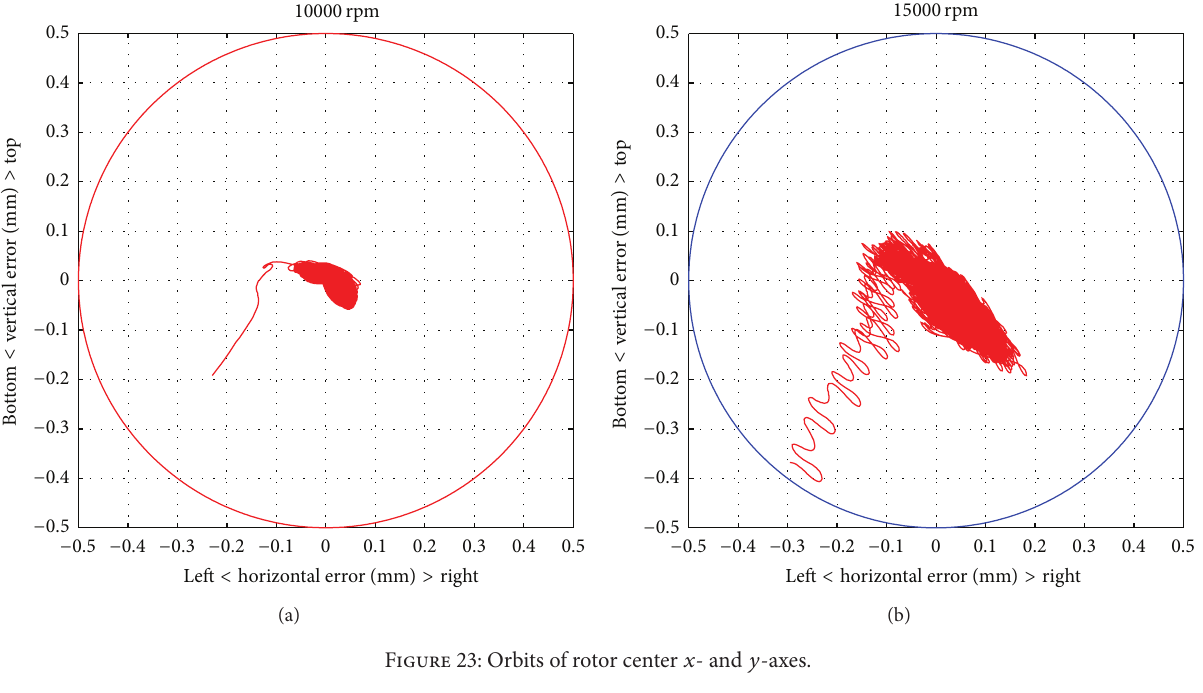
Figure 23: Orbits of rotor center 𝑥 - and 𝑦 -axes.